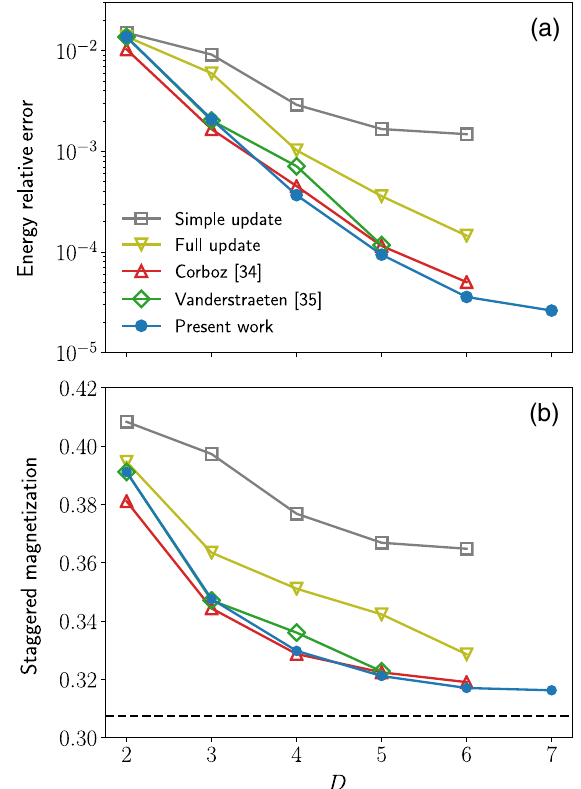
FIG. 4. (a) The relative error in the energy of the 2D S ¼ 1 = 2 antiferromagnetic Heisenberg model compared to previous varia- tional results [34,35]. The accuracy is measured relative to the extrapolated QMC result [95]. (b) A comparison of the staggered magnetization, where the dashed line is the extrapolated QMC result [95]. The simple and full update reference data are also from Ref.